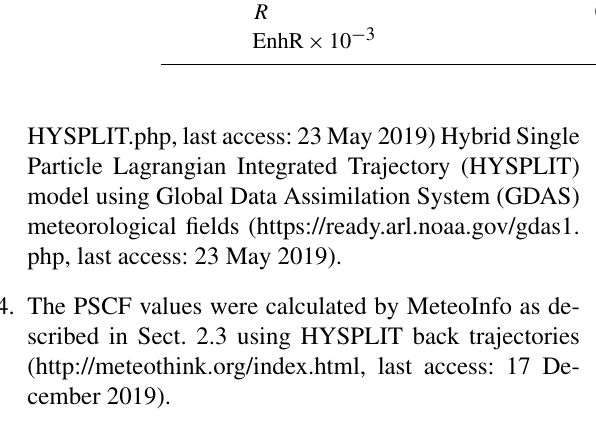
Figure 6. Correlation plots of daily mean partial columns (surface–15km) of HCN versus CO (moleculescm − 2 ). The linear equation of the fit and the resulting correlation coefficient r are shown. The black line is a linear least-squares fit of respective data. All stations are organized as a function of decreasing latitude. Error bars represent the retrieval uncertainties. Table 5. Correlation between HCN and CO tropospheric columns within each selected period at Hefei (32 ◦ N), China. N is the number of points, R is the correlation coefficient, and EnhR HCN is the enhancement ratio. Gas Period HCN